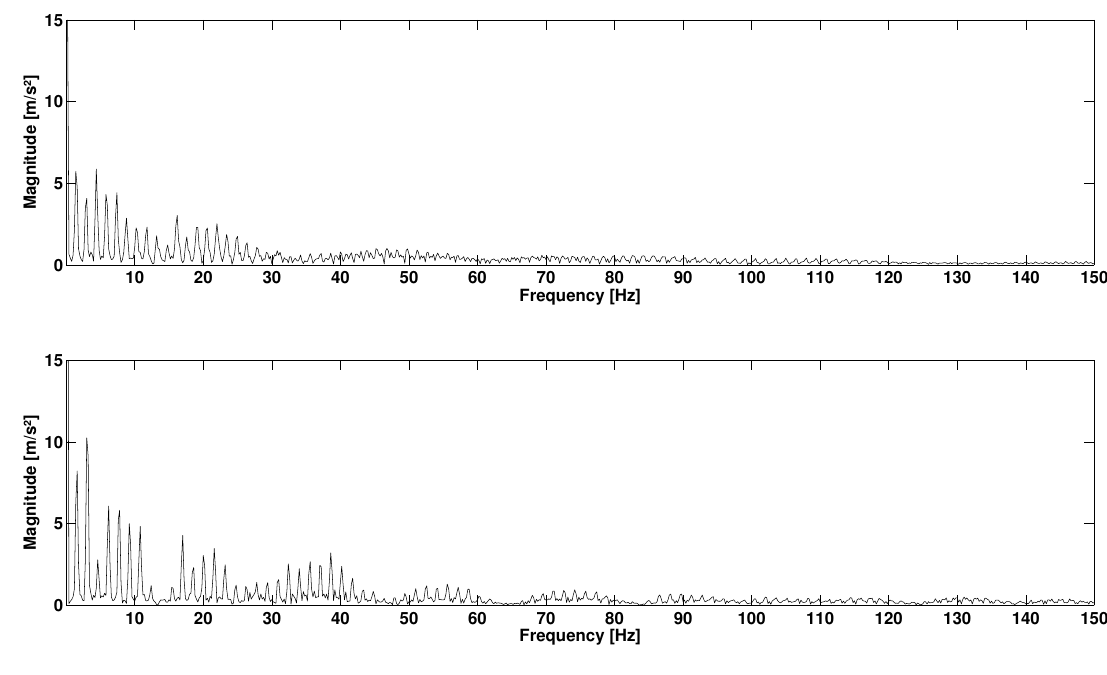
Figure 7. Total acceleration spectrum of the right leg reference sensor R 1344 at 8 km/h ( Top ) and 18 km/h ( Bottom